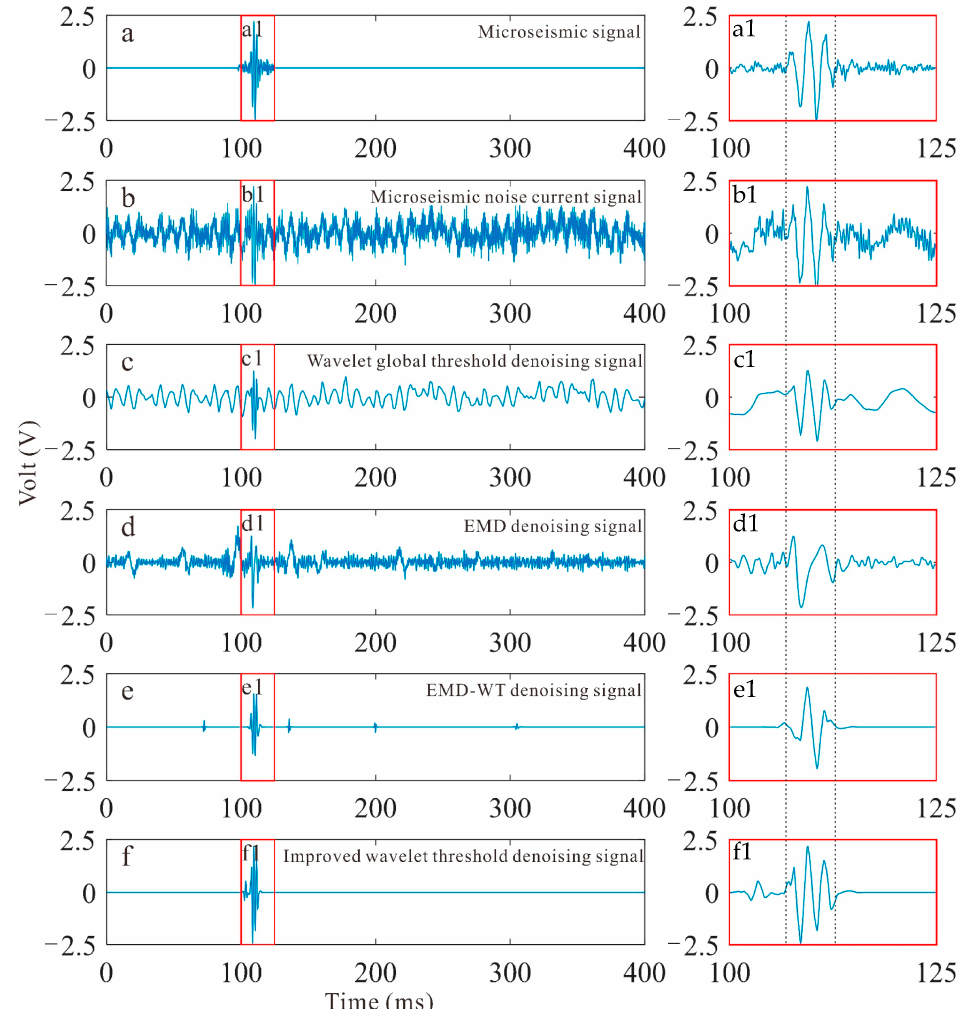
Figure 7. Comparison of the denoising results of the microseismic noise current synthesis signal: ( a , a1 ) microseismic signal, ( b , b1 ) microseismic noise current signal, ( c , c1 ) Wavelet global threshold denoising signal, ( d , d1 ) EMD denoising signal, ( e , e1 ) EMD-WT denoising signal, ( f , f1 ) improved wavelet threshold denoising signal.